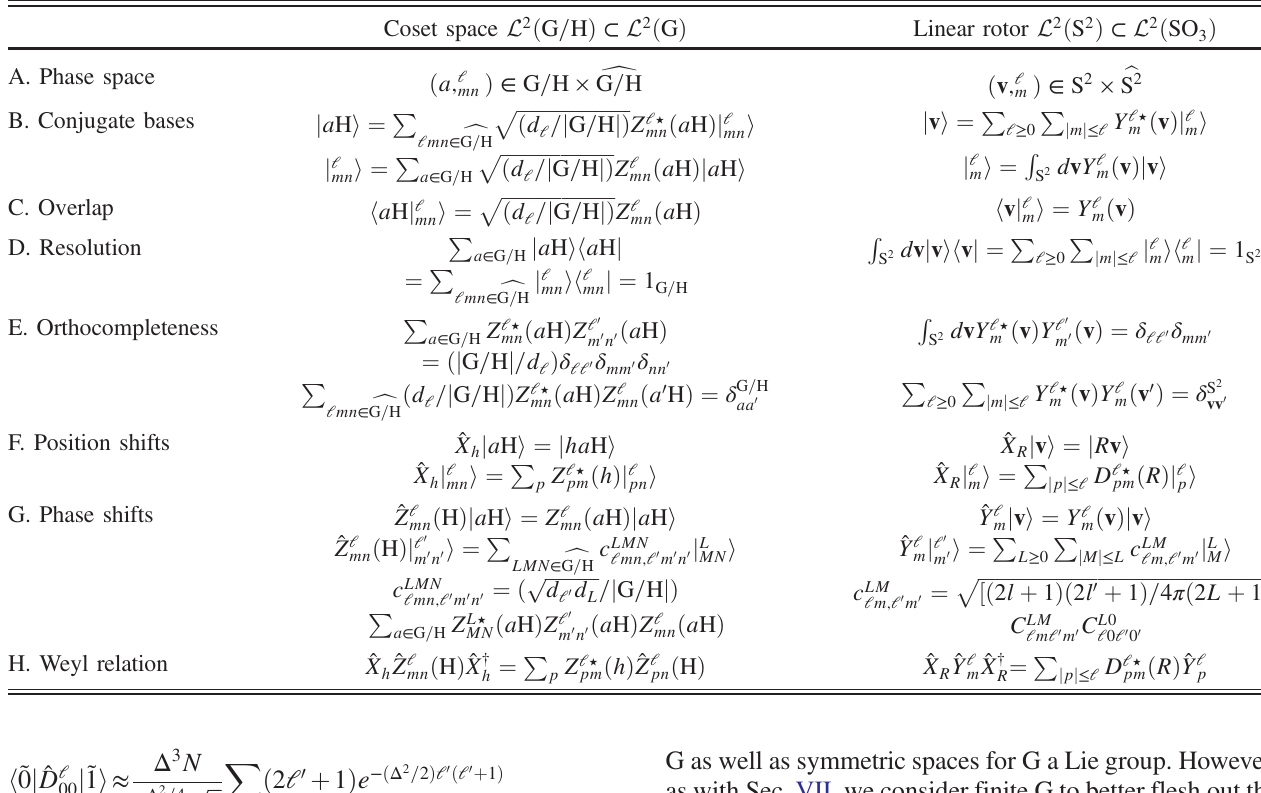
ˆ X ⃗ X is projected onto the quotient h h